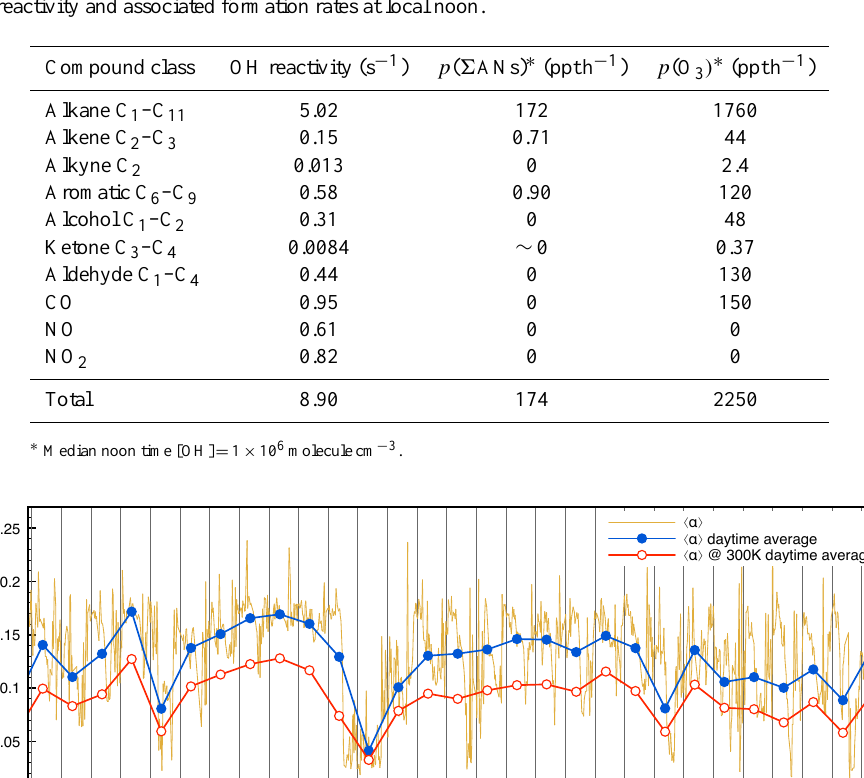
Table 1. Median OH reactivity and associated formation rates at local noon.